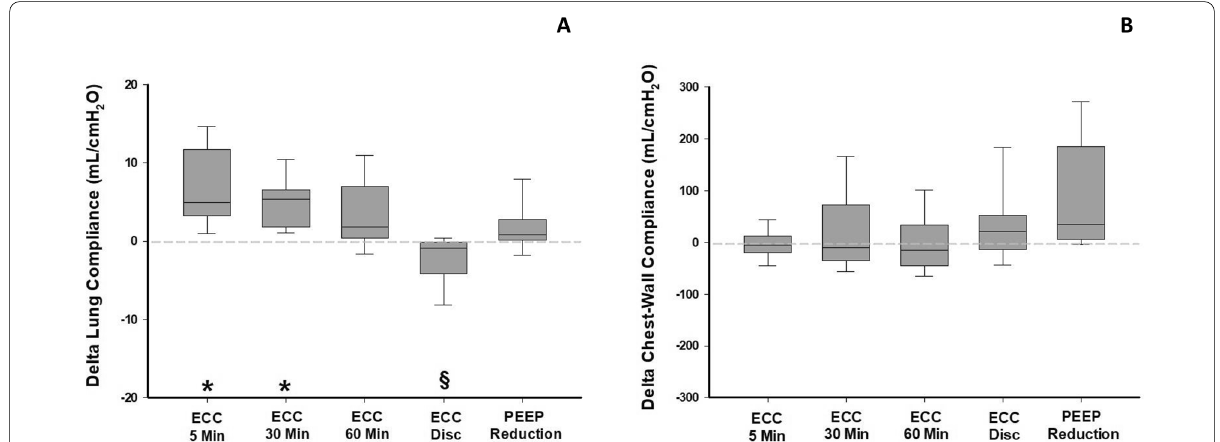
Fig. 3 Variations in partitioned respiratory mechanics. N 9. Box plot representation of variations in lung ( A ) and chest-wall ( B ) compliance = over the study period. Data are expressed as variation compared to baseline values (timepoint partitioned compliance—baseline partitioned compliance). The horizontal dashed line represents baseline. ECC external chest-wall compression. * P < 0.05 of absolute values of different timepoints vs. baseline, § P < 0.05 ECC discontinuation vs. ECC at 5, 30 and 60